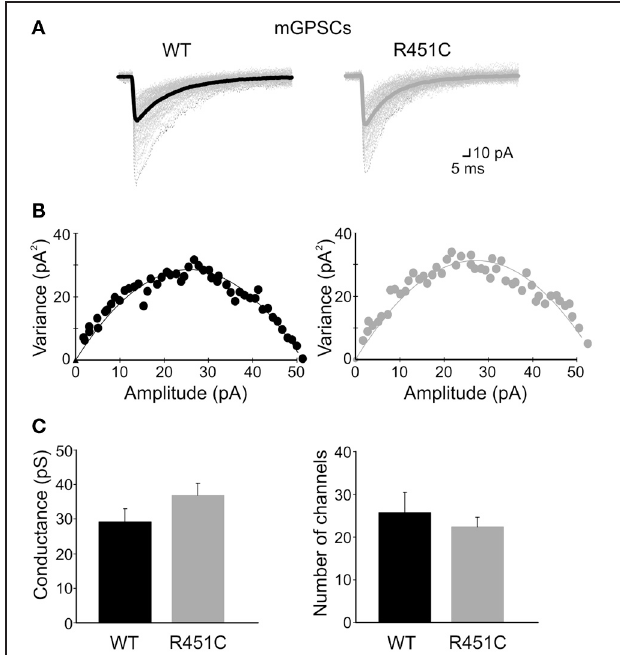
FIGURE 5 | The NL3 R451C knock-in mutation does not affect single channel conductance and/or the number of GABA A receptor channels. (A) Individual mGPSCs (dotted lines) are shown with the average currents (thick lines) in WT and R451C mice. (B) Current/variance relationships for mGPSCs shown in (A) . (C) Summary plots of weighted mean channel conductance and number of GABA A receptor channels in WT (black; n = 8) and in NL3 R451C knock-in mice (gray; n = 9